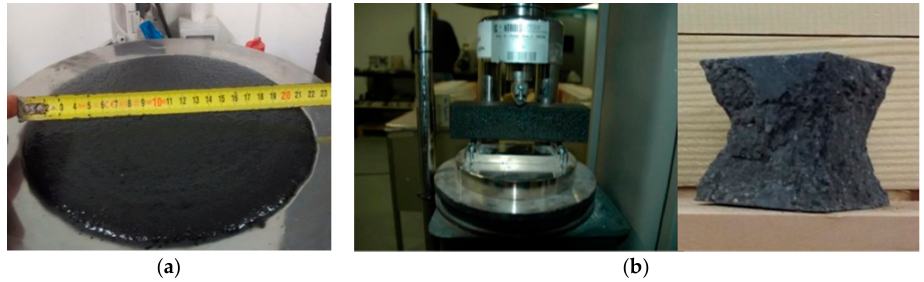
Figure 2. Testing on alkali-activated mortars: ( a ) flow spread measurement; ( b ) prismatic sample tested in flexural mode and aspect of a sample after a compression test.